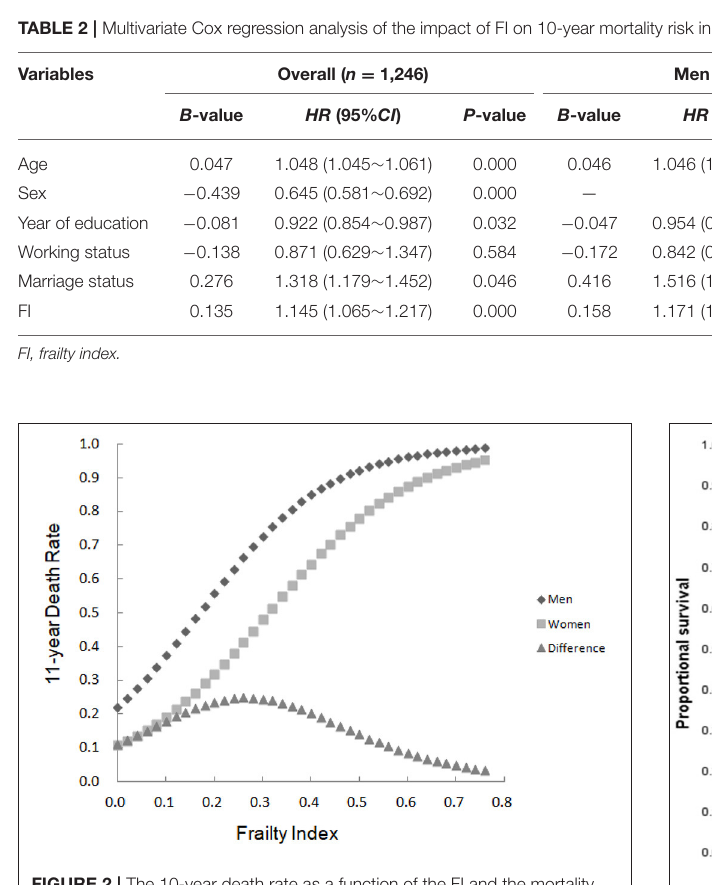
FIGURE 2 | The 10-year death rate as a function of the FI and the mortality difference between men and women.